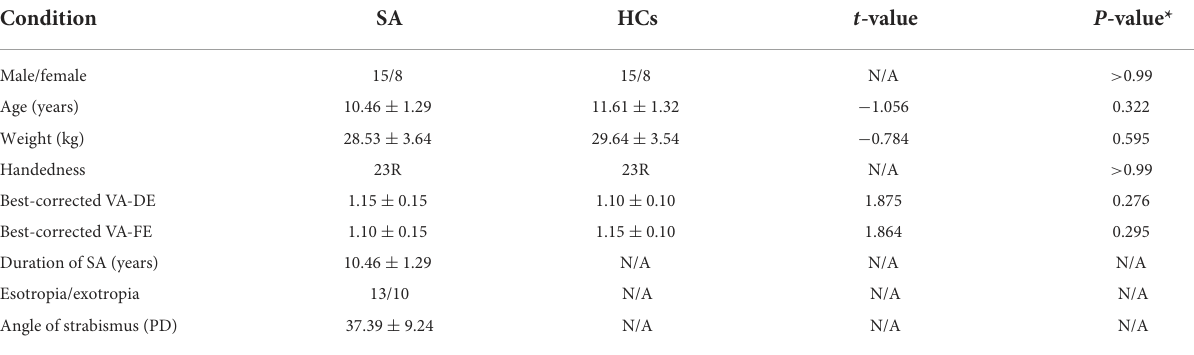
TABLE 1 The conditions of participants included in the